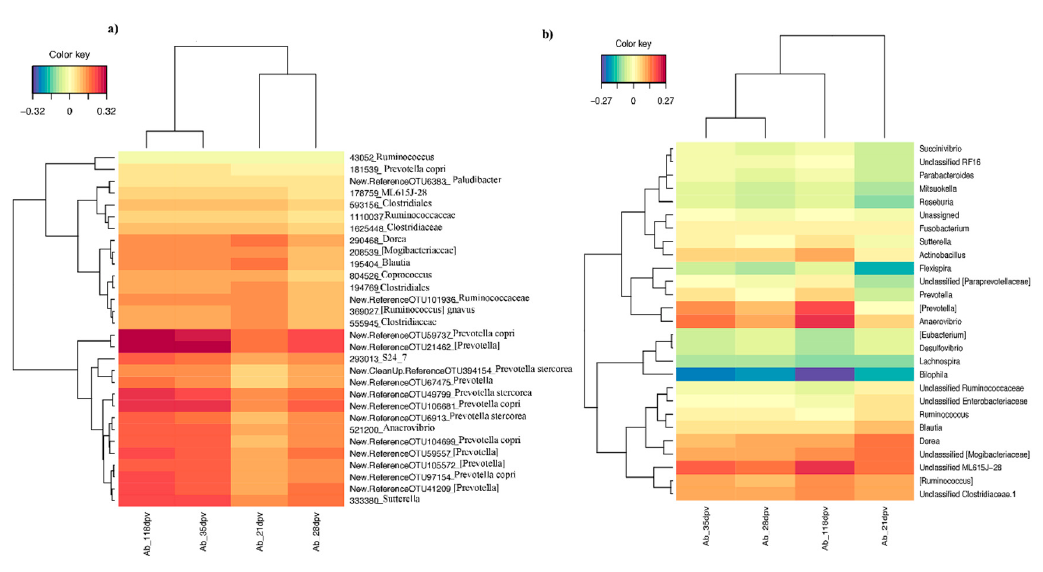
Figure 4. Unsupervised analysis and pre-vaccination feature selection with sparse partial least squares (sPLS) at 0 dpv based on the first two components. ( a ) Clustered Image Map showing the association between the sPLS-selected operational taxonomic units (OTUs) and antibody titers determined at 21, 28, 35, and 118 dpv; ( b ) clustered image map showing the association between the sPLS-selected taxa at genus level and antibody titers determined at 21, 28, 35, and 118 dpv. The dark brown color shows a positive association, whereas a dark blue color shows a negative association. Ab = antibody titers. Dpv—days post-vaccination.